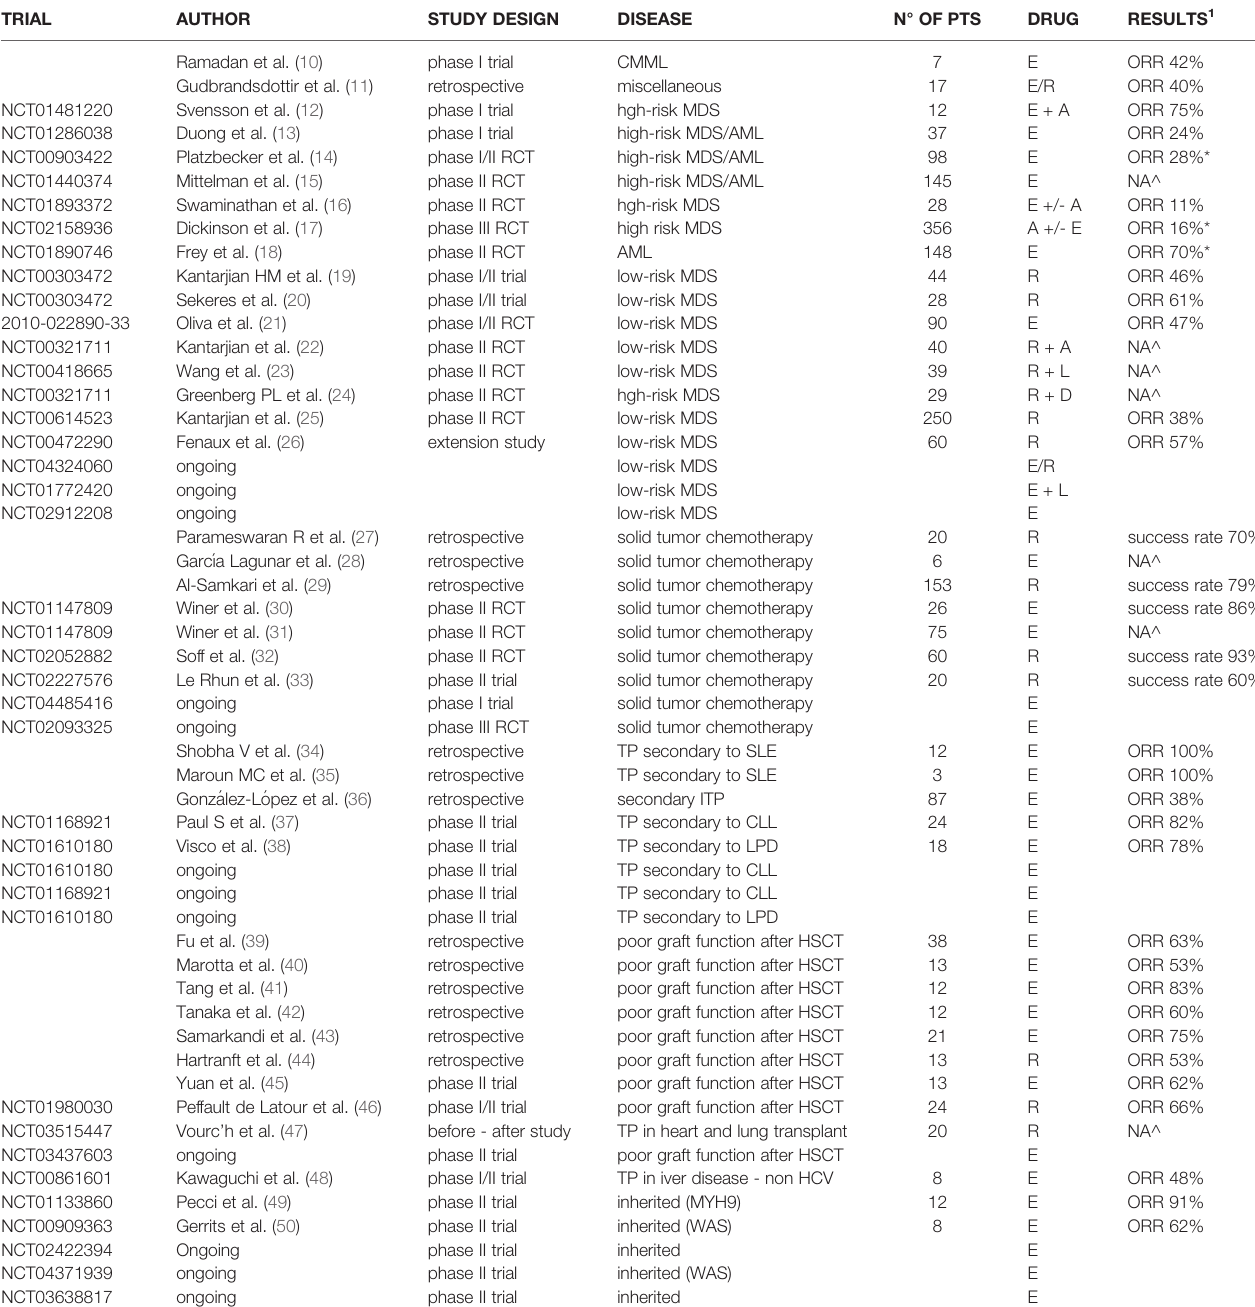
TABLE 2 | Published and ongoing studies with TPO-RA used in unlabeled